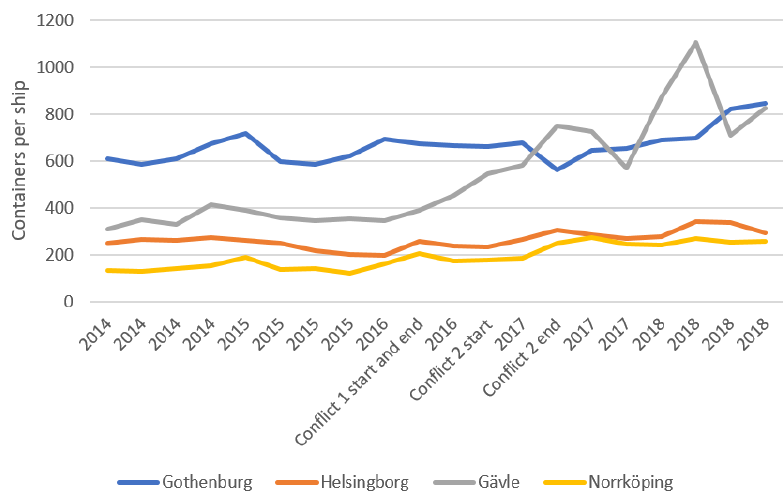
Figure 5. Containers per ship.